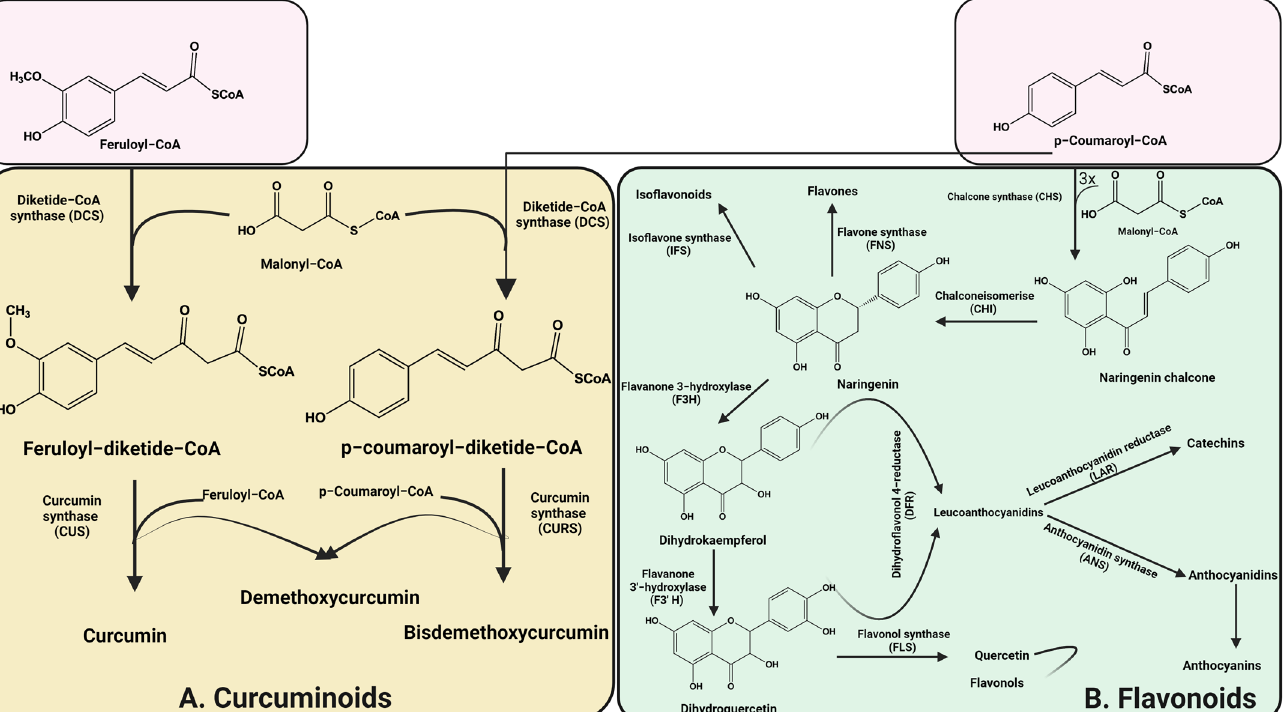
Figure 3. Structure of flavonoids and curcuminoids, major classes of polyphenols. This field of research has witnessed a continuously growing interest in flavonoid derivatives in recent decades due to their anti-inflammatory and anti-cancer effects, an-